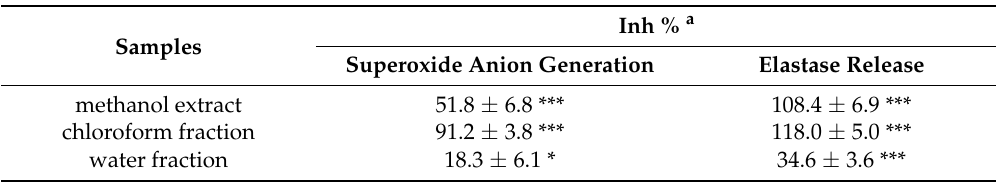
Table 1. Inhibitory percentages of crude extract and partial purified fractions of V. luteola on superoxide anion generation and elastase release by human neutrophils in response